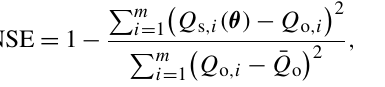
Table 1. A detailed description of the hydrological model can be found in Laiti et al. (2018) and Avesani et al.